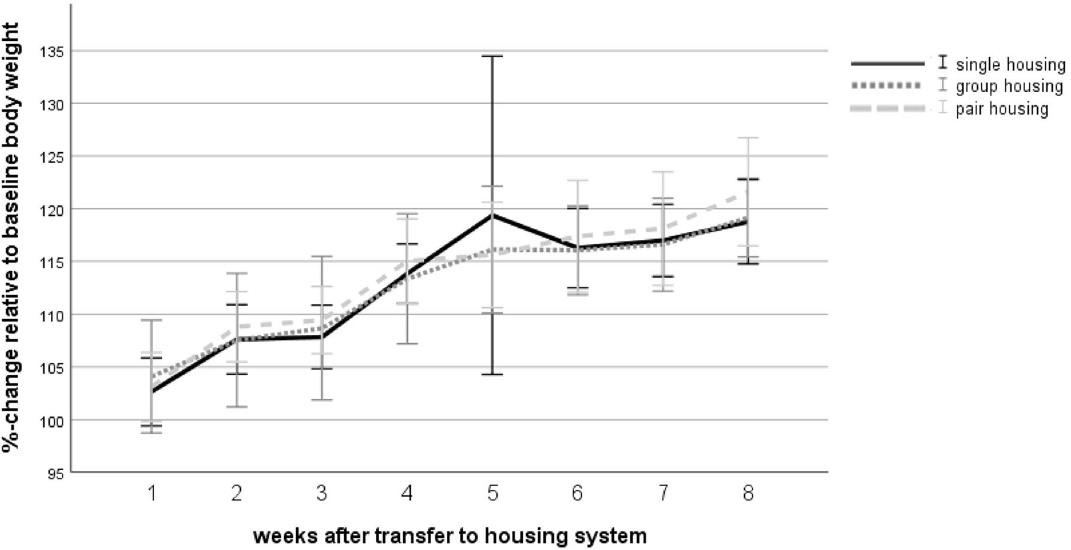
Figure 9. Body weight. Data are given as mean ± standard deviation. Single housing: n = 16, group housing: n = 16, pair housing: n = 16.